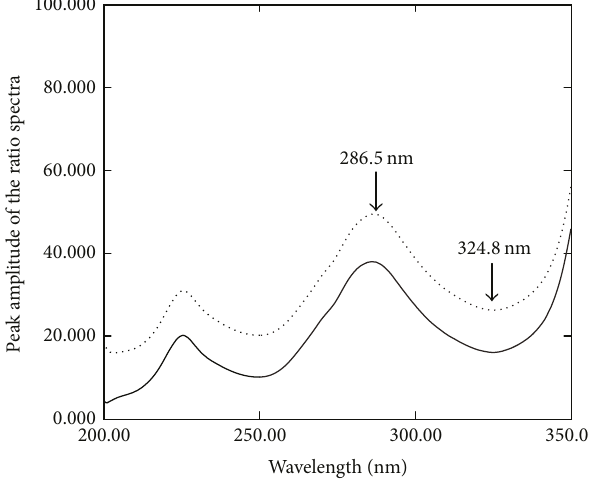
Figure 3: First-derivative absorption spectra of 60 𝜇 g/mL OXY (—) and 60 𝜇 g/mL FLU (------) using 0.1 NHCl as a blank. and FLU for determination of FLU and OXY, respectively.